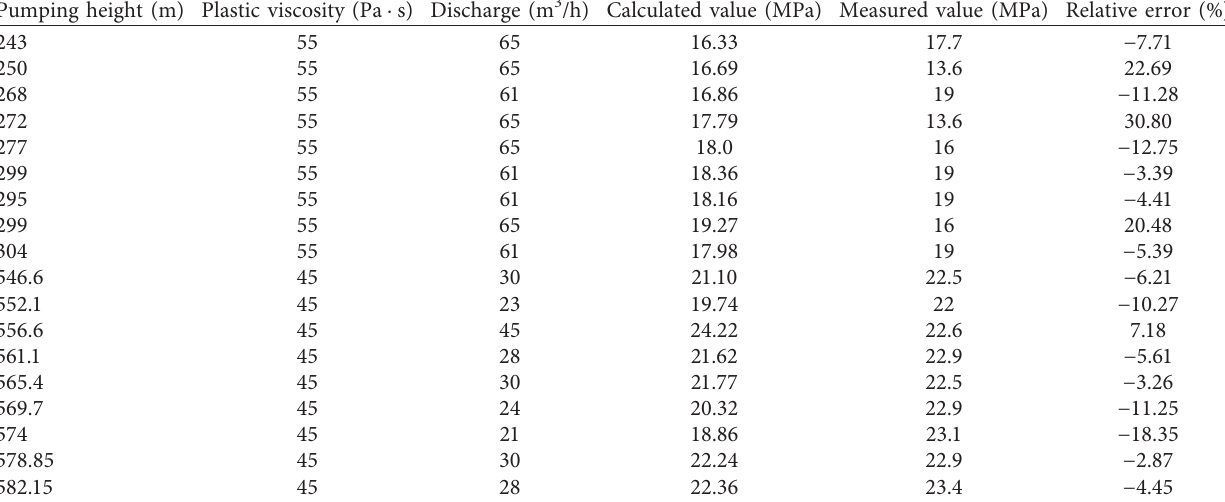
Table 2: The comparison for the calculated pressure value and measured